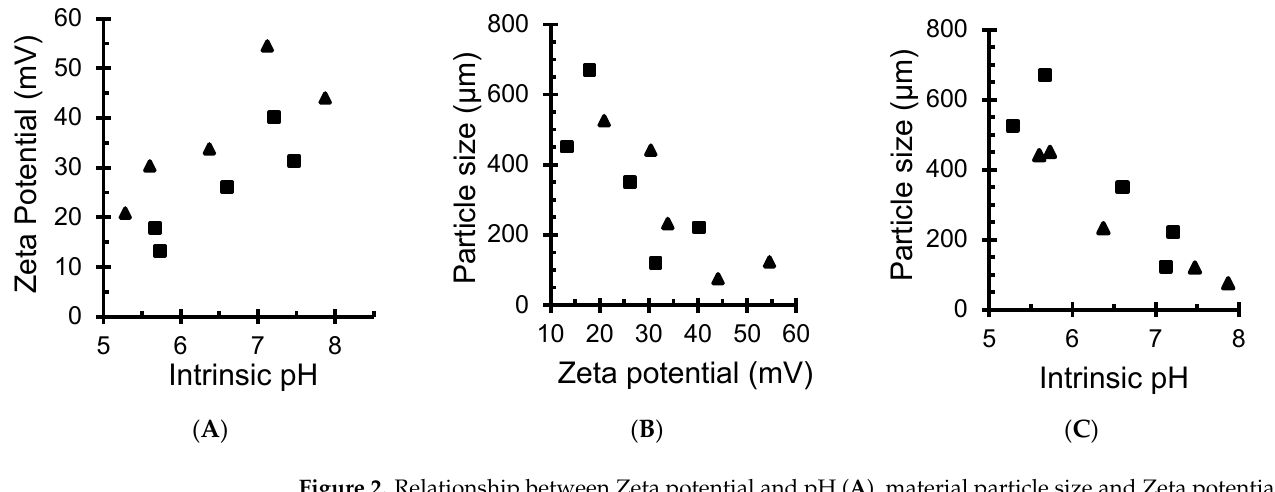
Figure 2. Relationship between Zeta potential and pH ( A ), material particle size and Zeta potential ( B ) and material particle size and pH ( C ) of the dispersion media. In black square: CMC-based samples, including CMC, Cu 2+/ CMC, Cu 0 /CMC, Ag + /CMC and Ag 0 /CMC. In black triangle: CMS-based samples, including CMS, Cu 2+/ CMS, Cu 0 /CMS, Ag + /CMS and Ag 0 /CMS.